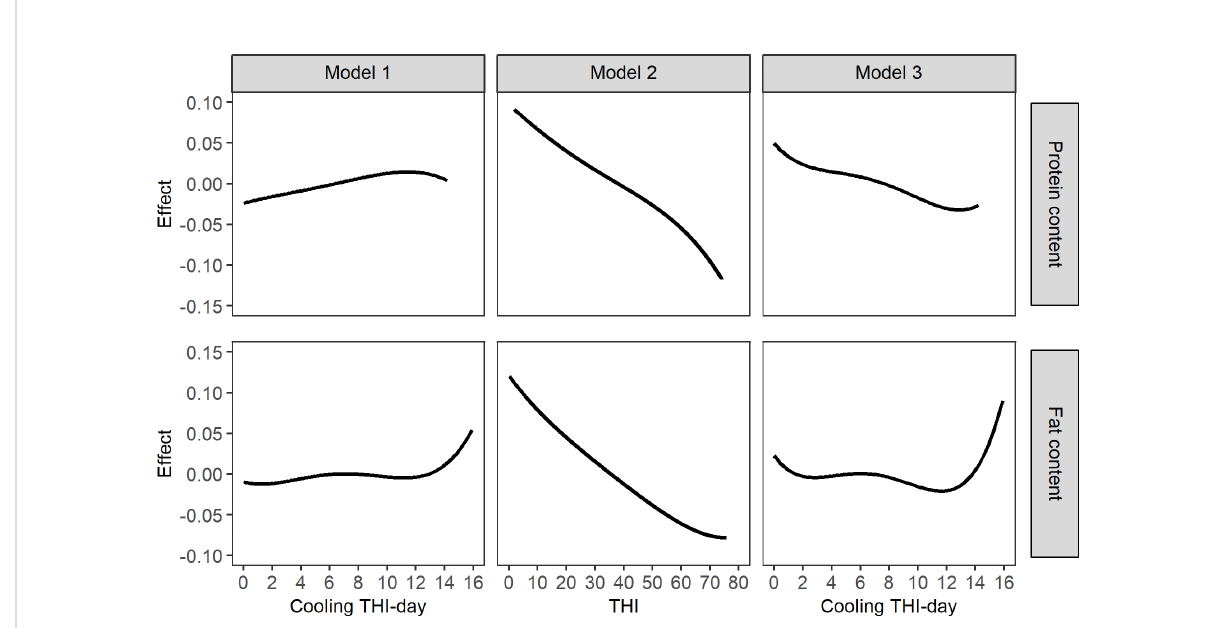
FIGURE 4 Reaction of protein content (top) and fat content (bottom) to THI and cooling THI-day full model (left; plot is for cooling THI-day), THI (middle), and cooling THI-day